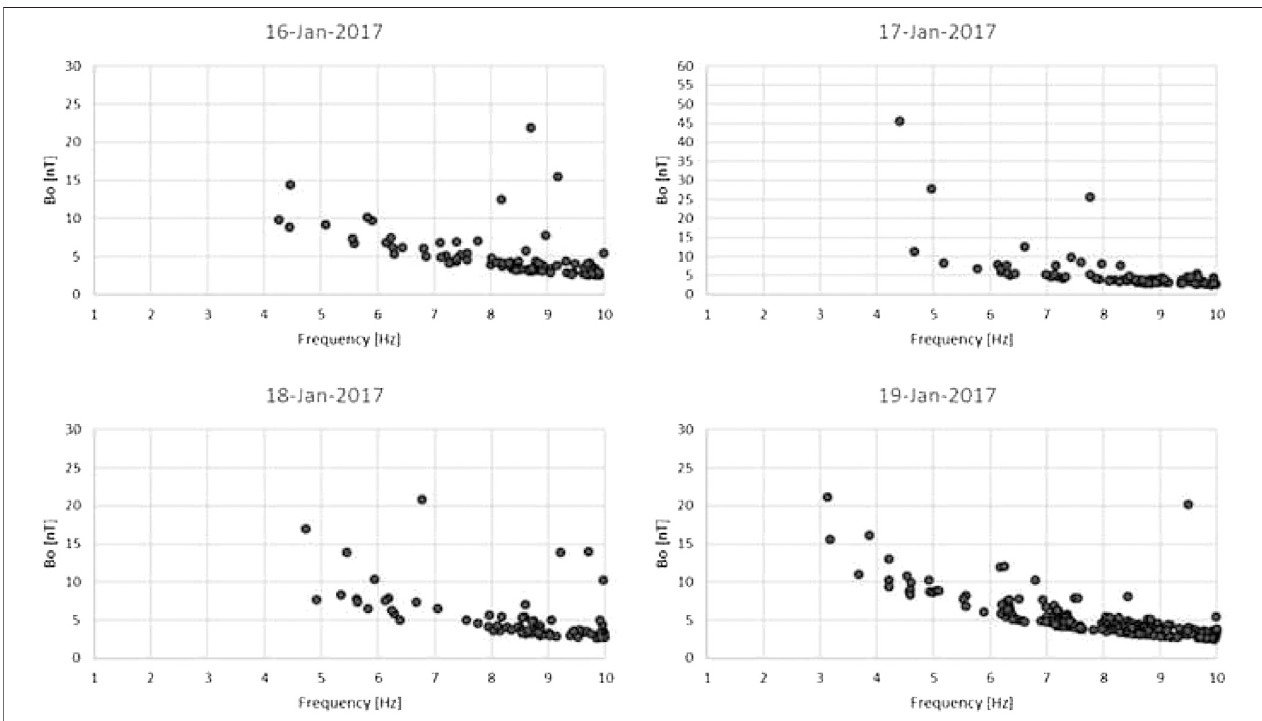
FIGURE 8 | The daily spectra from 16 to January 19, 2017. A day before the main shock in Capitignano (January 18, Mw (cid:1) 5.5), three pulses with amplitudes greater than 20 nT appeared in the band between 4 and 8 Hz and even during the day ofthe main shock in Capitignano apulse and the day after two pulses between 3 and 10